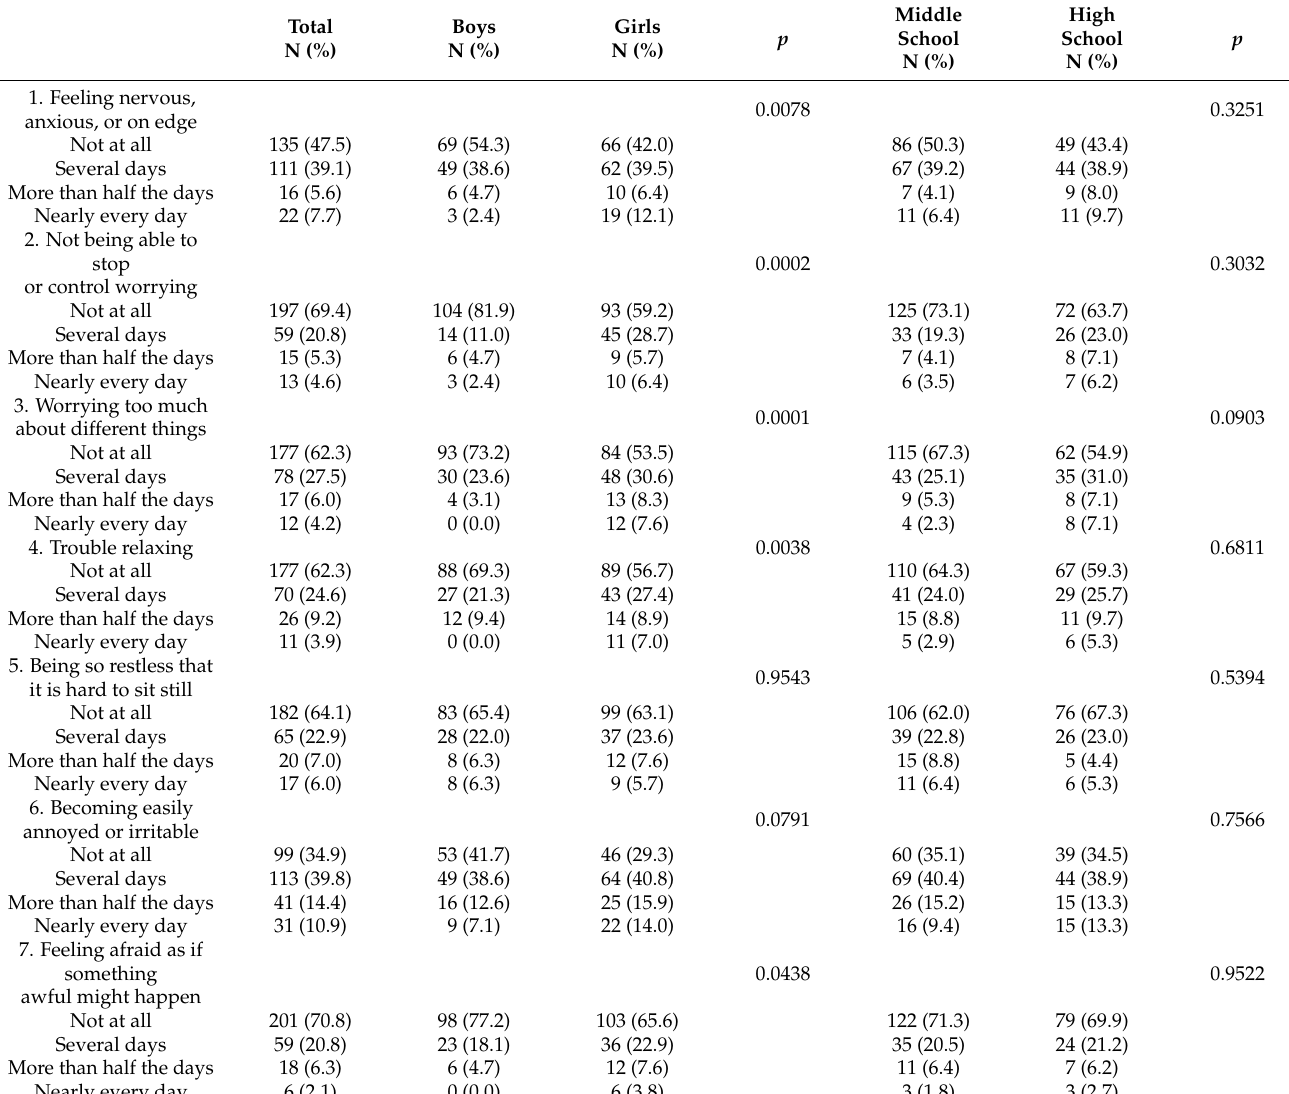
Table 3. GAD-7 item scores (N = 284).